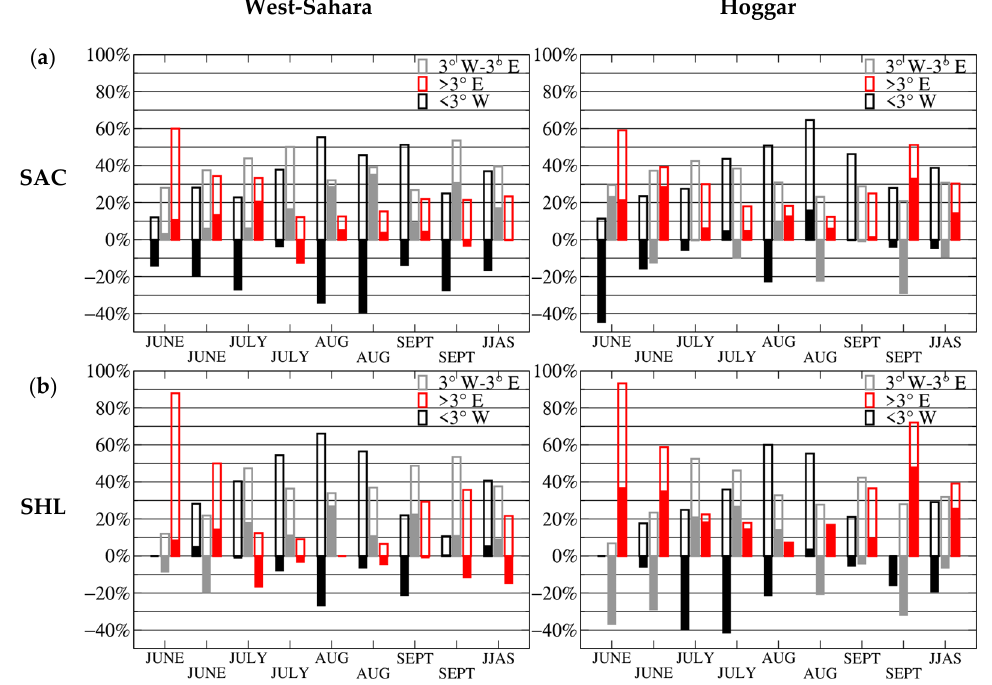
Figure 10. ( a ) For the SAC barycenter for mid-top days, occurrence frequency of the barycenter longitude on the west of 3 ◦ W (yellow contour), between 3 ◦ W and 3 ◦ E (cyan contour) and on the east of 3 ◦ E (brown contour). ( b ) For the SHL barycenter and for mid-top days, occurrence frequency of the barycenter longitude on the west of 3 ◦ W (yellow contour), between 3 ◦ W and 3 ◦ E (cyan contour) and on the east of 3 ◦ E (brown contour). The fill part of the bar gives the difference in frequency between mid-top days and clear days. Data estimated over 15 days periods. Information is given for West-Sahara (left column) and for Hoggar (right